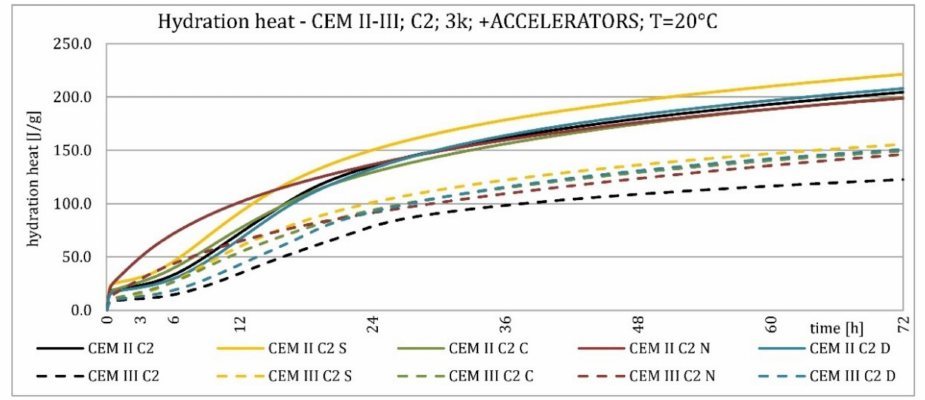
Figure 23. Hydration heat of C2 clinker-based cements CEM II/B-S, CEM III/A modified with accelerators at 20 ◦